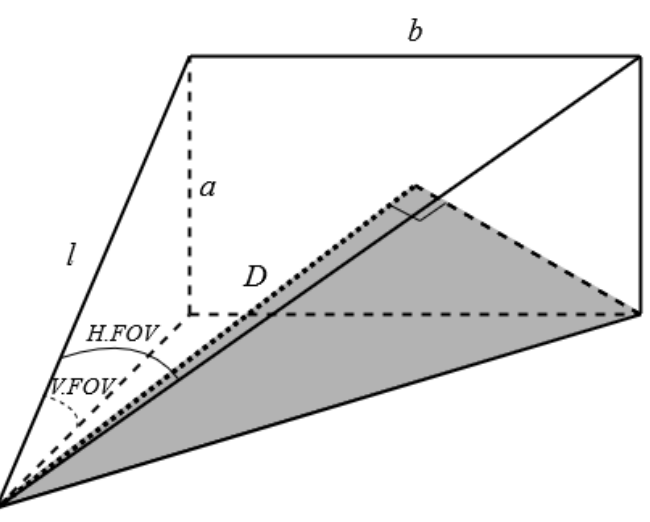
Figure 8. The camera’s area of